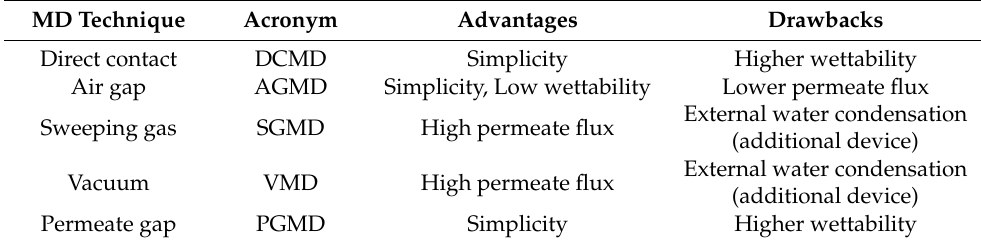
Table 1. Comparison of different membrane distillation techniques